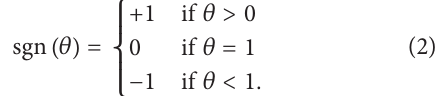
Table 1: Descriptive statistics and Mann-Kendall trend analysis test for the time series data of rice cultivation in Odisha and India from 1950-51 to 2006-07. Parameters Mean Median Standard deviation Kurtosis Skewness All India Area (million